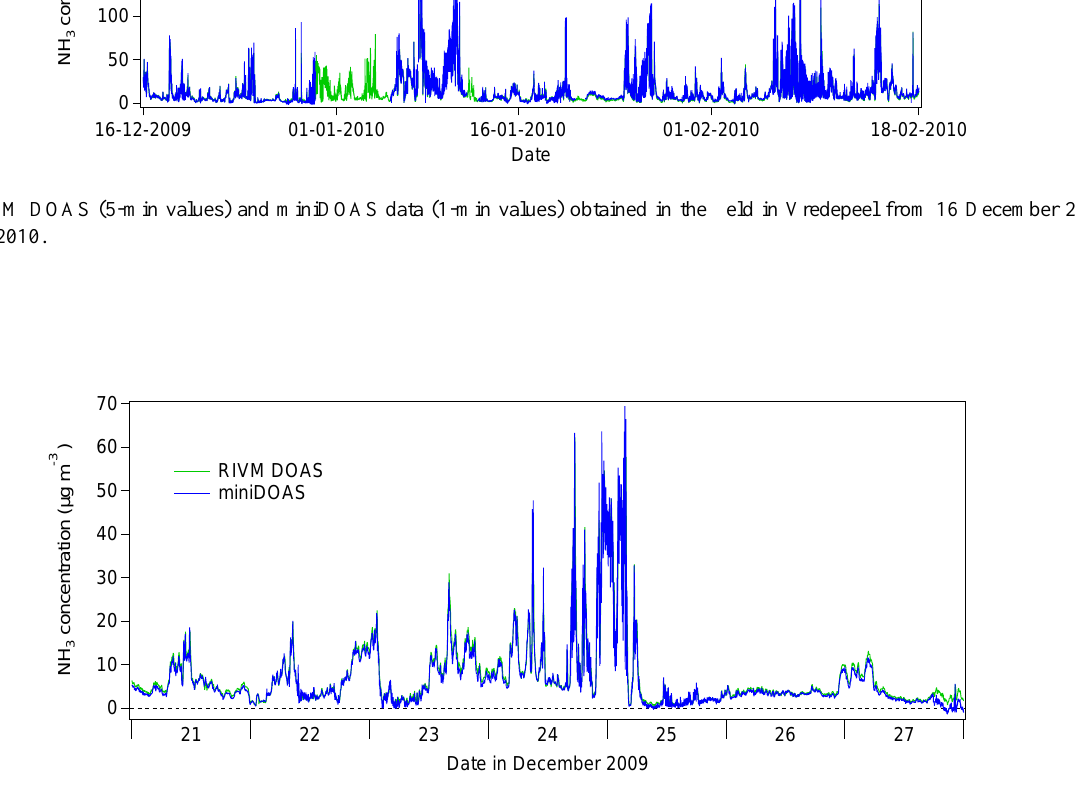
Fig. 14. Zoom in on the RIVM DOAS (5-min values) and miniDOAS data (1-min values) obtained in the field in Vredepeel from 21 to 28 December 2009.